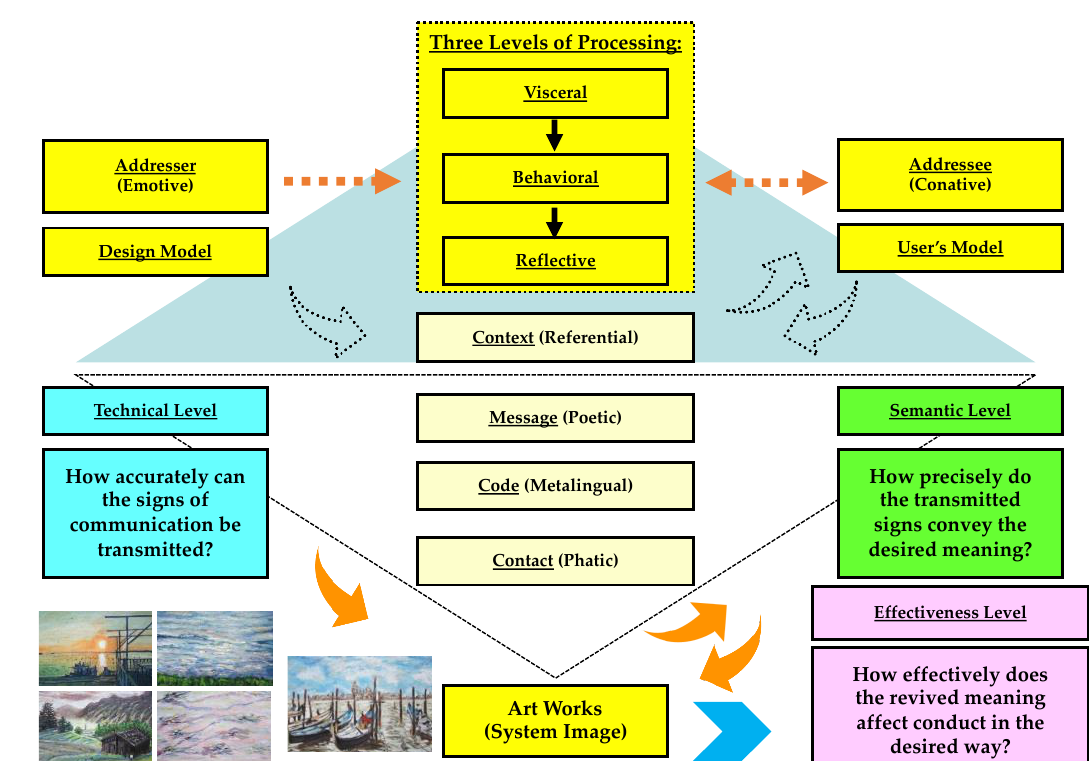
Figure 1. The six corresponding factors and functions of artistic communication. (Reprinted with permission from [24]. Copyright 2017 Lin, R. et al.).